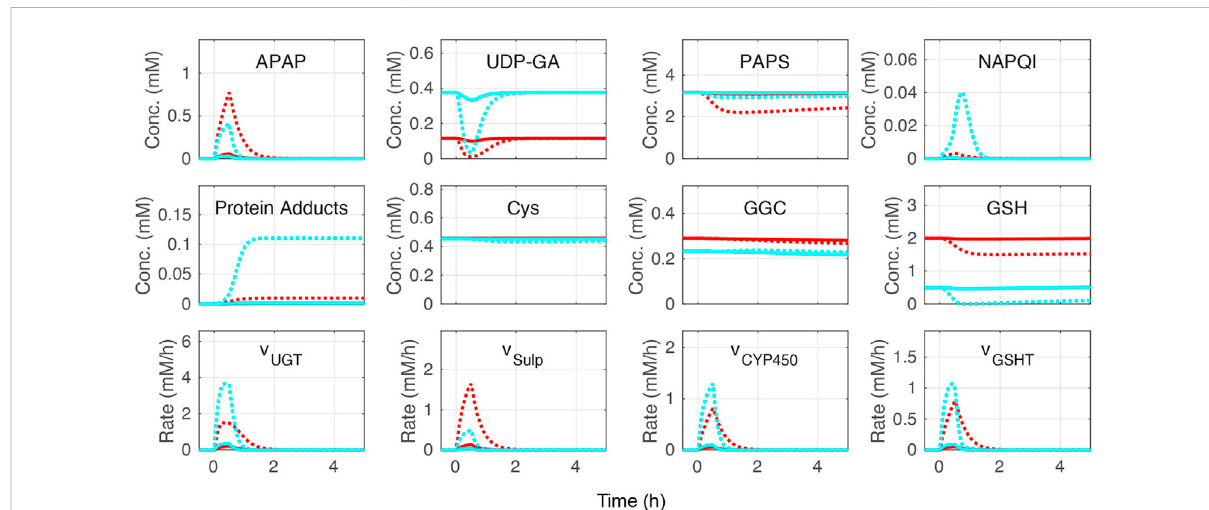
FIGURE 5 Simulationofacetaminophen(APAP)metabolism.APAPwasadministeredfortheinitial30 minofthesimulation.Theredandbluelinesindicate the periportal and pericentral regions, respectively. The solid and dotted lines indicate moderate (0.5 mM/h) and excessive (6.0 mM/h) APAP administration, respectively. The de fi nitions of the abbreviations are listed in Supplementary Material.